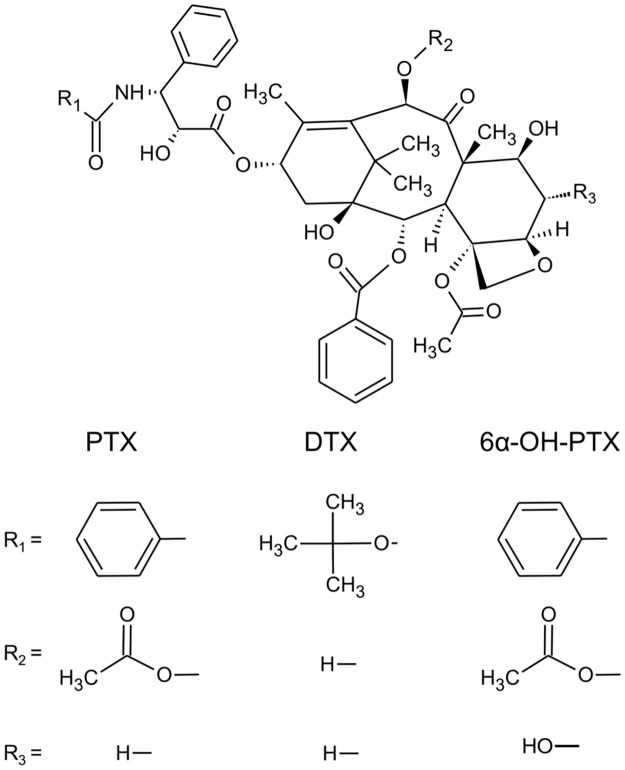
Chemical structures of PTX, 6α-OH-PTX, and DTX (docetaxel) used as IS.